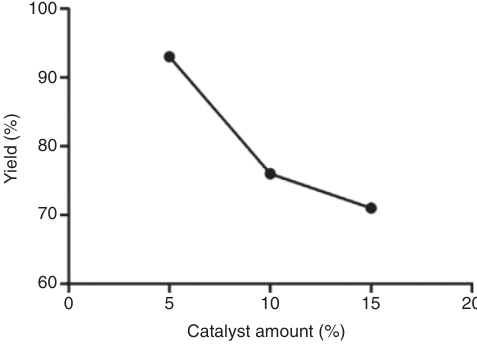
Figure 2: Effect of catalyst amount on yield of 11,15-dimethyl- hexadeca-8,10,14-trien-7-one. (2-Octanone/citral molar ratio of 10, 60 ° C, 3.5 h).